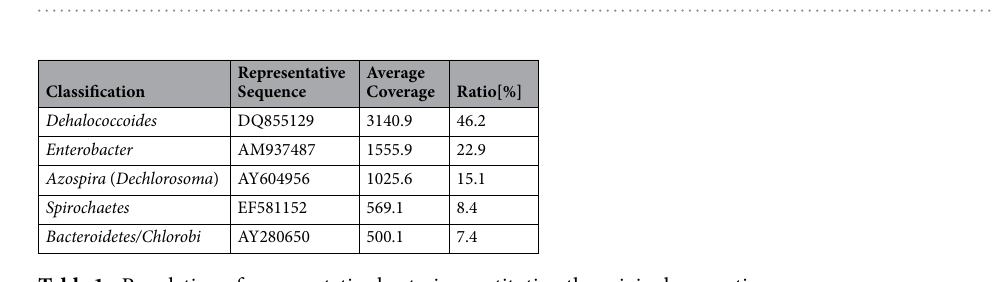
Figure 3. Coverage of SOLiD 3 Plus tag sequences for Dehalococcoides 16S rRNA and RDase genes. Tag sequences of the metagenome of the consortium by SOLiD 3 Plus were matched to sequences of Dehalococcoides 16S rRNA, bvcA , vcrA and tce A genes.